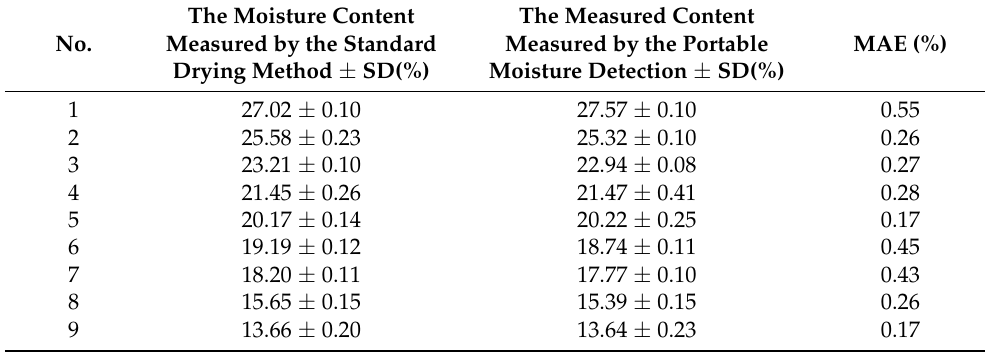
Table 2. Comparison of measurement results of samples with different moisture